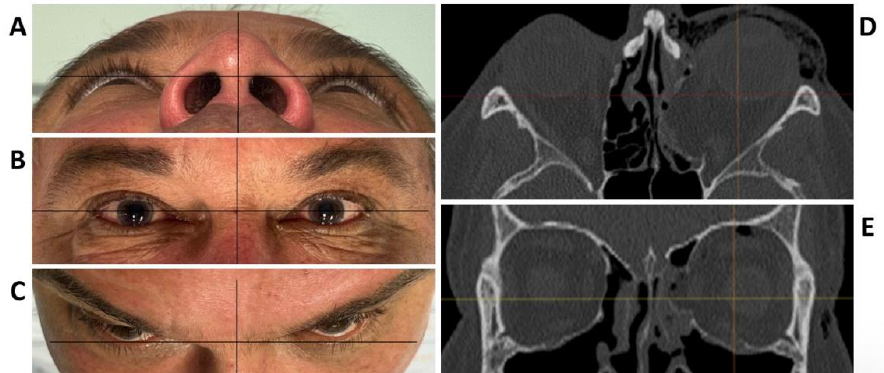
Figure 1. Clinical photographs of the patient showing an enophthalmos in the perspective from below ( A ), and above ( C ), while there is no hyper- or hypoglobe present as visible in the frontal view ( B ). Axial ( D ) and coronal ( E ) plane of the pre-operative CT scan displaying the traumatic defect of the medial wall and floor of the left orbit.